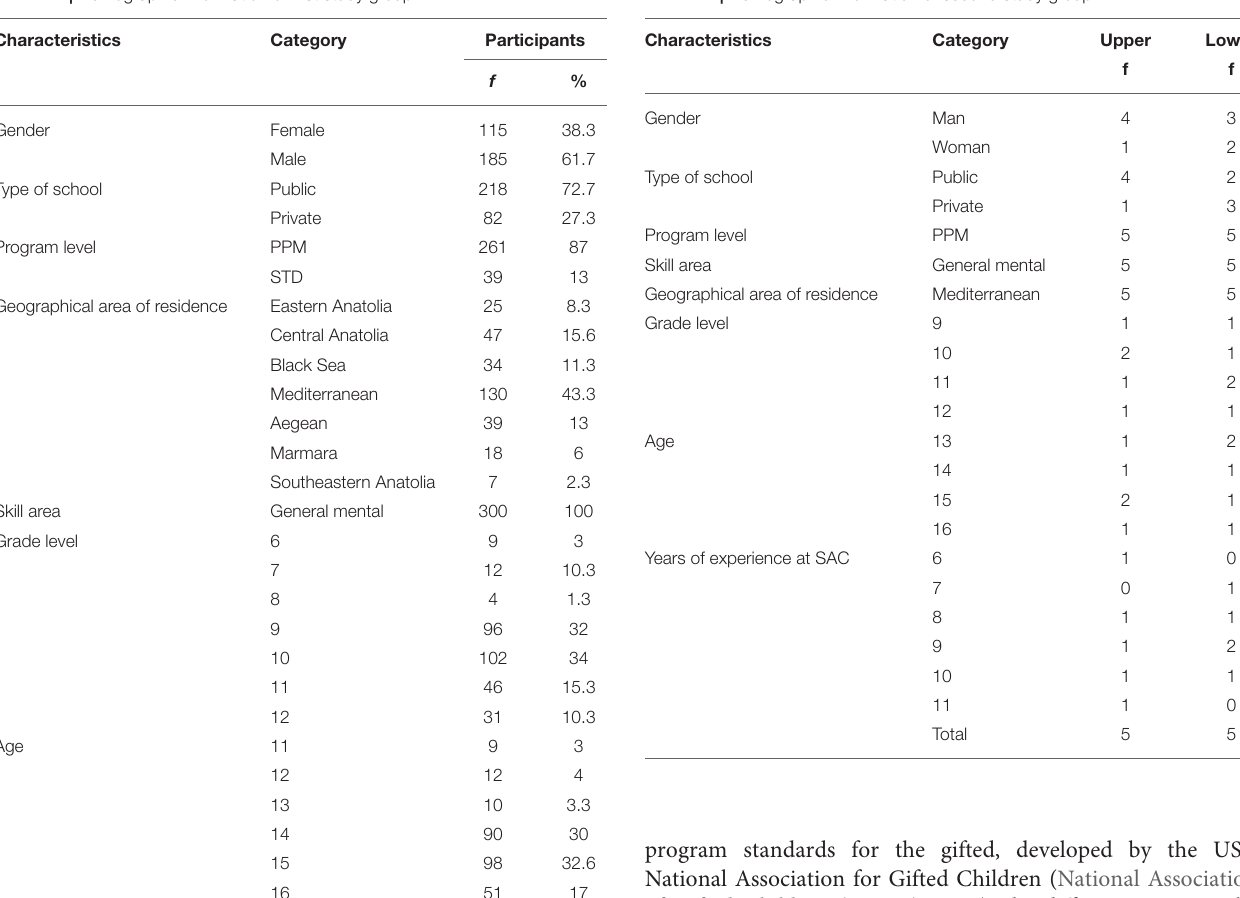
TABLE 1 | Demographic information of first study group. TABLE 2 | Demographic information of second study